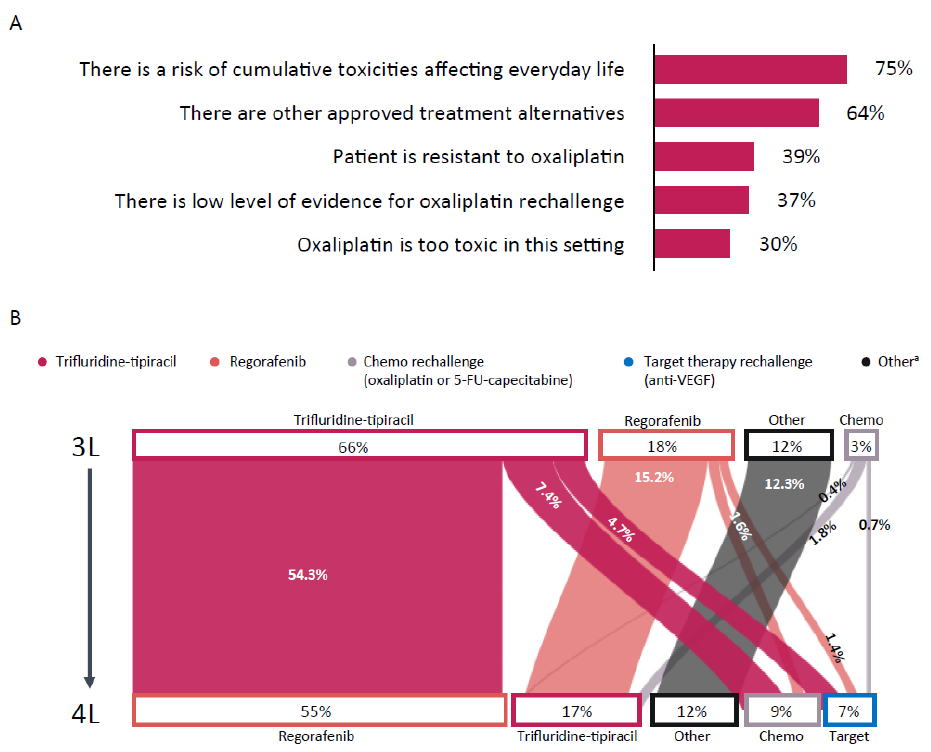
Figure 4. ( A ) Physicians’ responses on why oxaliplatin rechallenge is an unsuitable third-line treat- ment in a KRAS -mutant patient with comorbidities and previous tolerability issues, and ( B ) physi- cians’ responses on the preferred treatment strategy for a patient with KRAS -mutant tumor, comorbidities, and previous tolerability issues. 3L = third line; 4L = fourth line; 5-FU = 5-fluorouracil; VEGF = vascular endothelial growth factor. a Defined as unspecified.